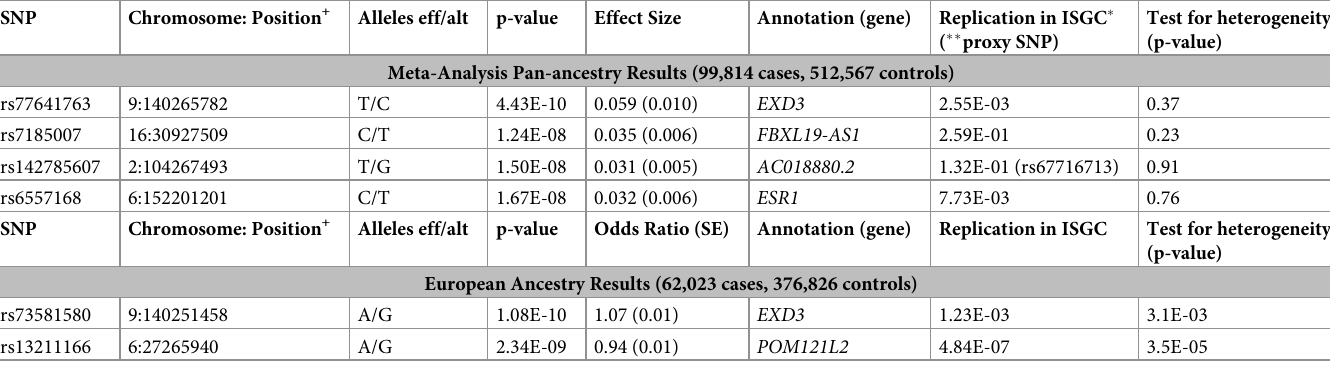
Table 2. Genome-wide Significant (p < 5E-8) Loci for Single Marker GWAS of Suicidal Ideation.